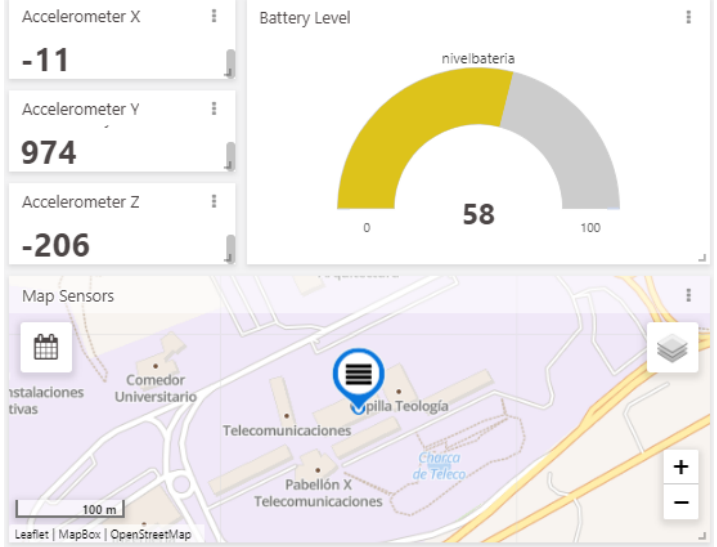
Figure 15. Sensors data received by LoRaWAN.